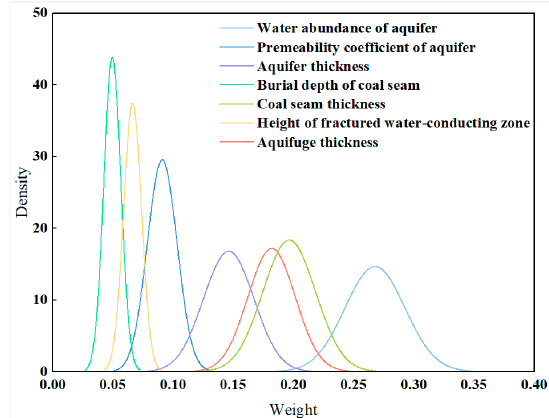
Figure 8. Criteria weight distribution function.